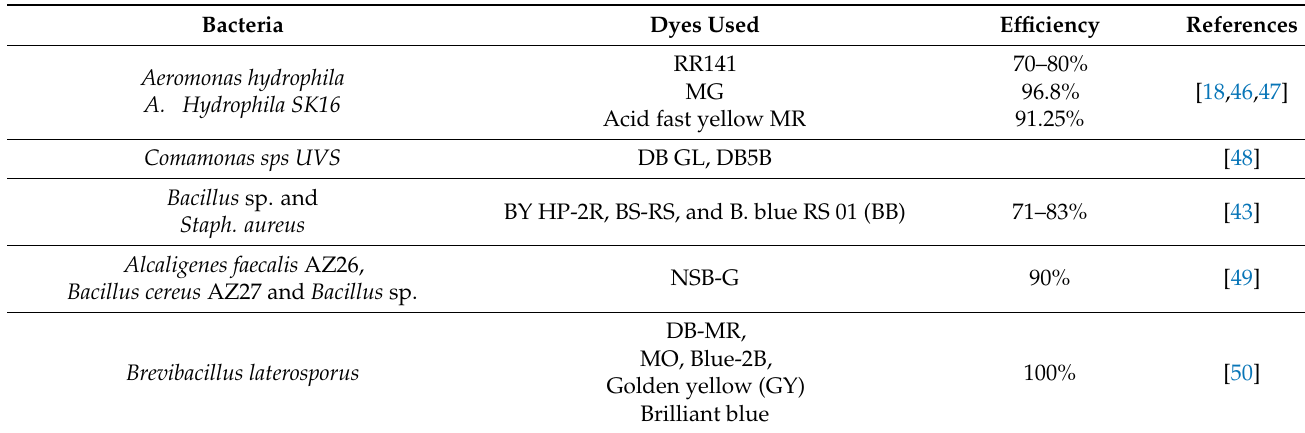
Table 2. Microbial remediation of dyes by using aerobic and aerobic